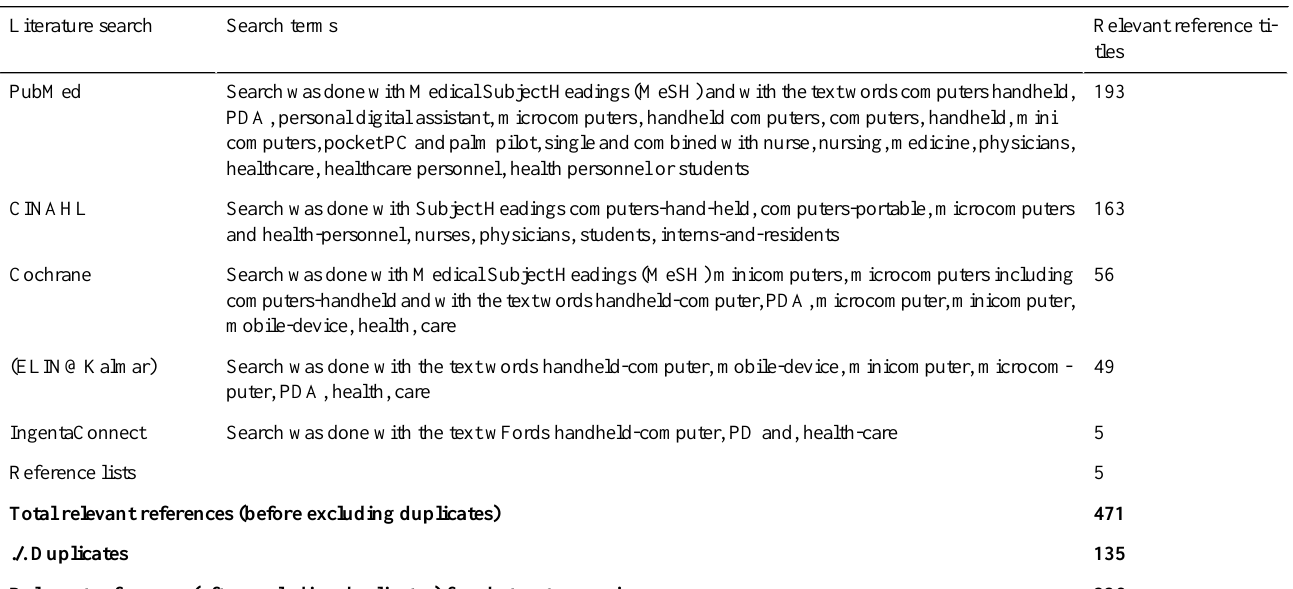
Table 1. Literature search—search terms and relevant reference titles